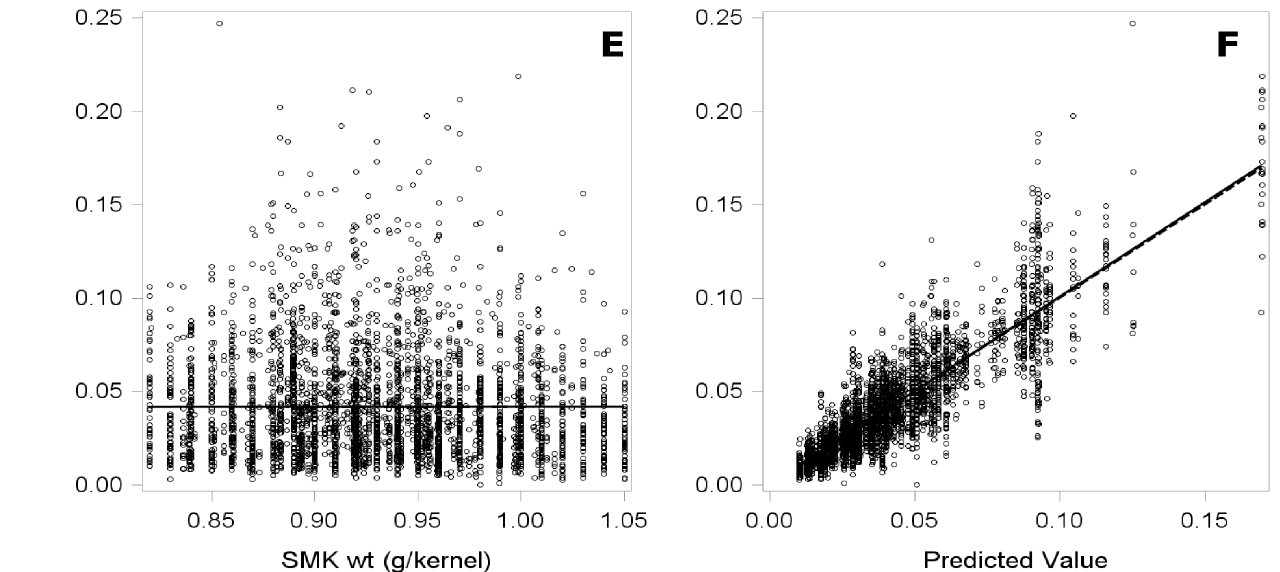
Figure 1. ( A , C , E ) Proportion sound splits (SS) predicted by sound mature kernel (SMK) wt (g/kernel) for ( A , C ) runner market types shelled with a ( A ) runner-type or a ( C ) Virginia-type sheller screen and ( E ) Virginia market types shelled with a Virginia-type sheller screen on a reciprocating sheller. Corresponding plots of observed versus predicted proportion sound splits are shown in panels ( B , D , F ), respectively. ( A ) Where the estimated slope parameter was significant, the shaded band corresponds to the 95% confidence interval. Predictions were estimated according to the following function with a beta distribution for the response: SS ij = b × SMKwt i + I + S j + e ij . S j and e ij were the random effect of study and the residual, respectively. Estimated slope ( b ) and intercept ( I ) model-scale parameters, slope, and intercept parameter p values, study variance ( S j ), and concordance correlation coefficients for each model were ( A , B ) 1.16, − 2.80, <0.001, <0.001, 0.161, and 0.775, ( C , D ) − 0.222, − 3.475, 0.687, <0.001, 0.398, and 0.930, and ( E , F ) 0.00957, − 3.145, 0.939, <0.001, 0.413, and